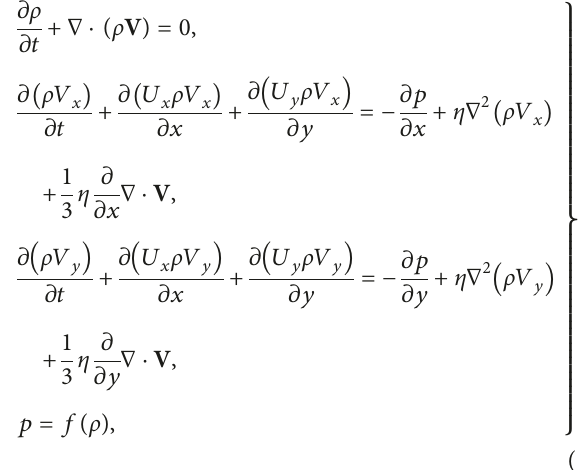
Figure 8: Flow of soft-matter quasicrystal past a circular cylinder with the radius a , reprinted from ref. [11], copyright 2017 with permission from Springer